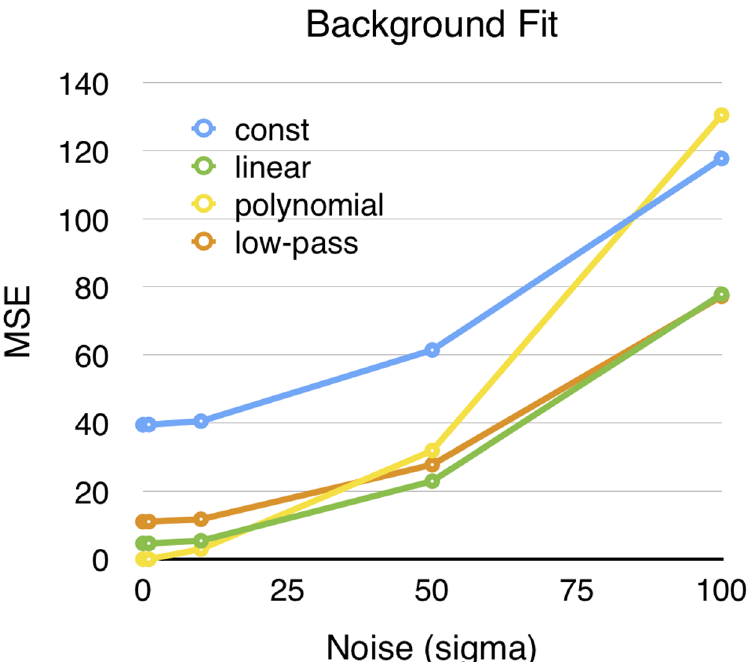
Fig 8. Mean squared error (MSE) of the background estimation on artificial bleaching data with different amounts of noise. A noise level of 25 means that the sigma of the gaussian noise was set to 25 times the range of the bleaching